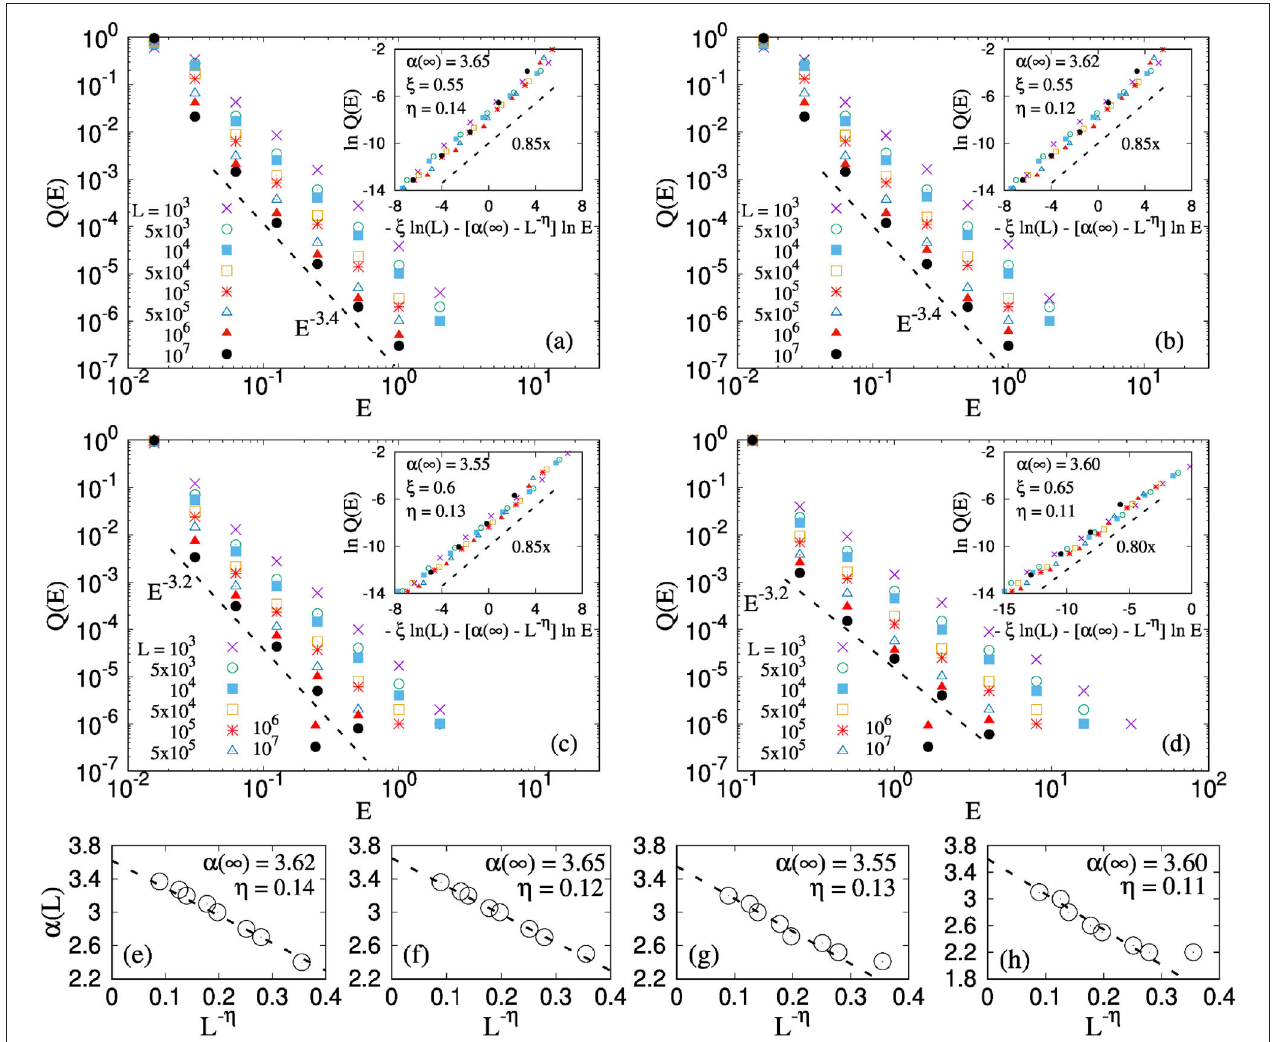
FIGURE 6 | (a) Distribution of energies for four different threshold distributions: (a) Linearly increasing [0:1], (b) Linearly decreasing [0:1], (c) Scale free distribution of exponent 2 between 0 and 1, (d) Weibull distribution with scale factor 1.0 and Weibull modulus 1.0. The system sizes varies in between 10 3 and 10 7 . The results are shown for LLS FBM. We observe a scale free distribution for E : Q ( E ) ∼ E − α for all thresholds. The insets of figures (a–d) shows the system size collapse given by Equation (15). (e–h) Shows the exponent α ( L ) to obey the scaling showed in Equation 16. The value of η for above mentioned distributions are 0.14, 0.12, 0.13, and 0.11 respectively, similar to what is observed in the system size